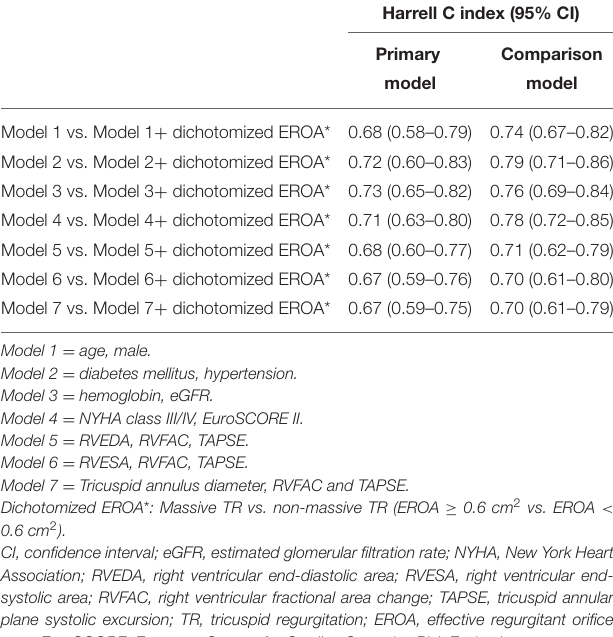
TABLE 4 | Better discrimination of a prediction model after including dichotomized EROA.